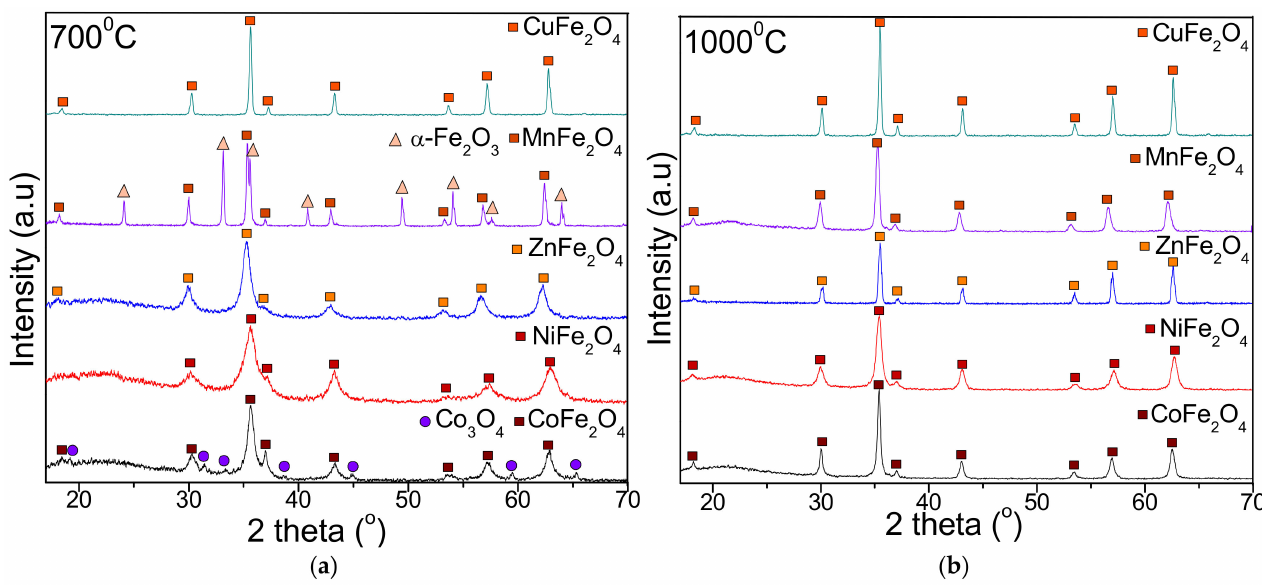
Figure 2. X-ray diffraction pattern of MFe 2 O 4 (M = Co, Ni, Zn, Mn, Cu) heat treated at 700 ◦ C ( a ) and 1000 ◦ C ( b ).